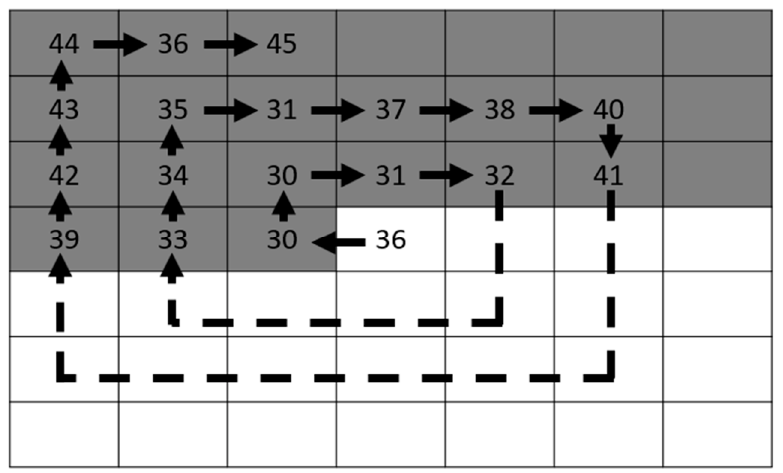
Figure 3. An example of SOC.